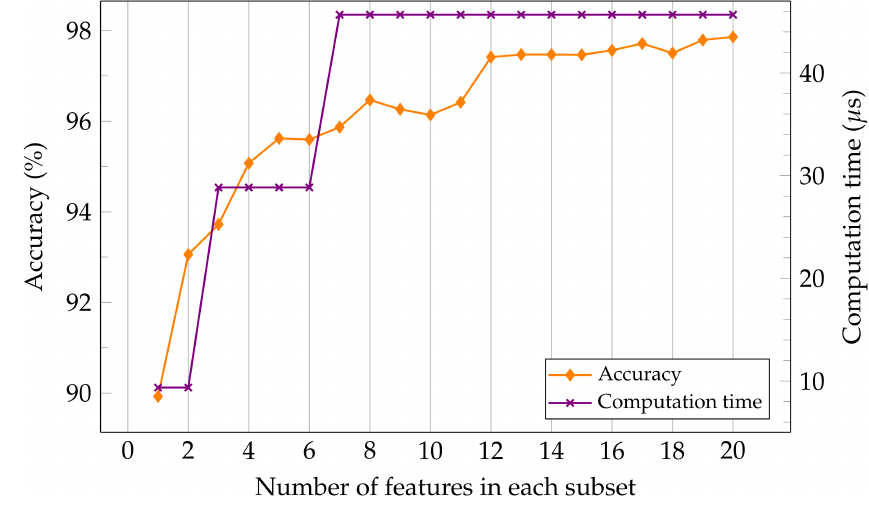
Figure 7. Trade-off between accuracy and computation time for different subsets of